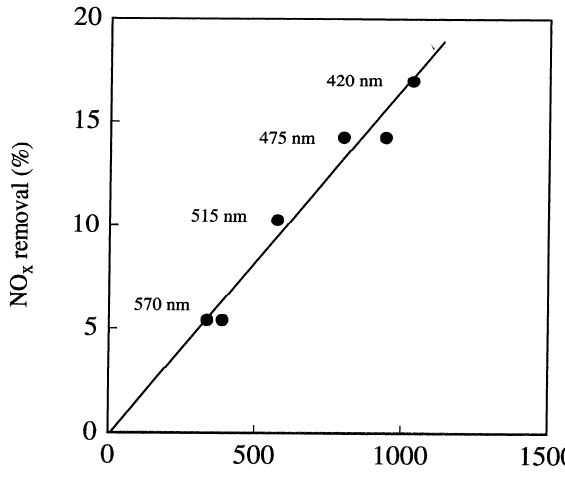
Figure 7. The removal of NOx as a function of the saturated intensity of ESR signal at different wavelengths from the visible light region. Reprinted with permission from [22]. Copyright 2000, Elsevier.